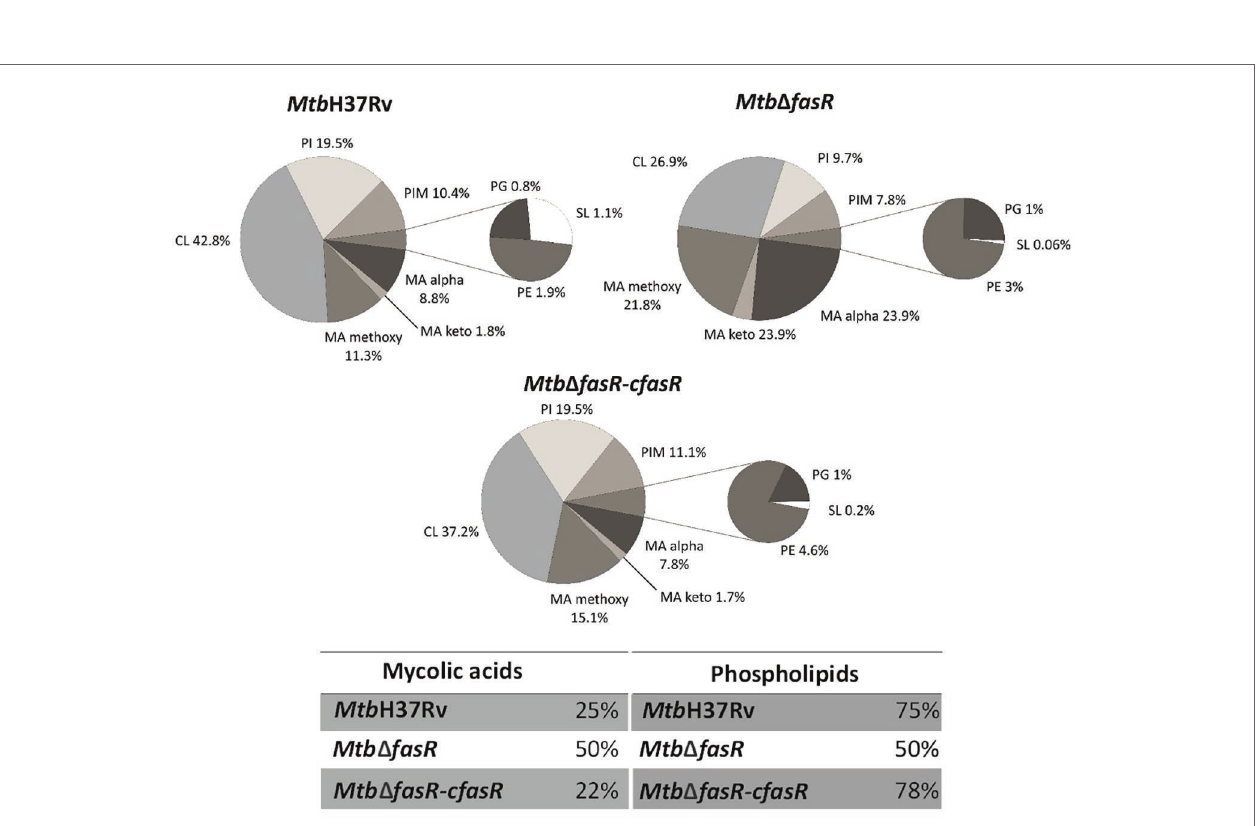
FIGURE 3 | Lipid profile in negative ion mode. LC-MS analyses (negative mode) of the phospholipids and mycolic acids present in M. tuberculosis wild type strain ( Mtb H37Rv), fasR complemented strain ( Mtb ∆ fasR -c fasR ), and fasR KO strain ( Mtb ∆ fasR ). The values indicated represent the relative abundance of the MS signals corresponding to the different lipid classes found in the samples. Results are the means of three independent experiments. CL, cardiolipin; PI, phosphatidylinositol; PIM, phosphatidylinositol mannosides; PG, phosphatidylglycerol; PE, phosphatidylethanolamine; SL, sulfolipids; MA, mycolic acids.